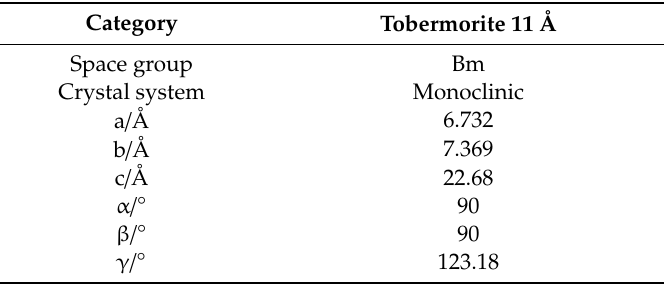
Table 1. Lattice parameters of tobermorite 11